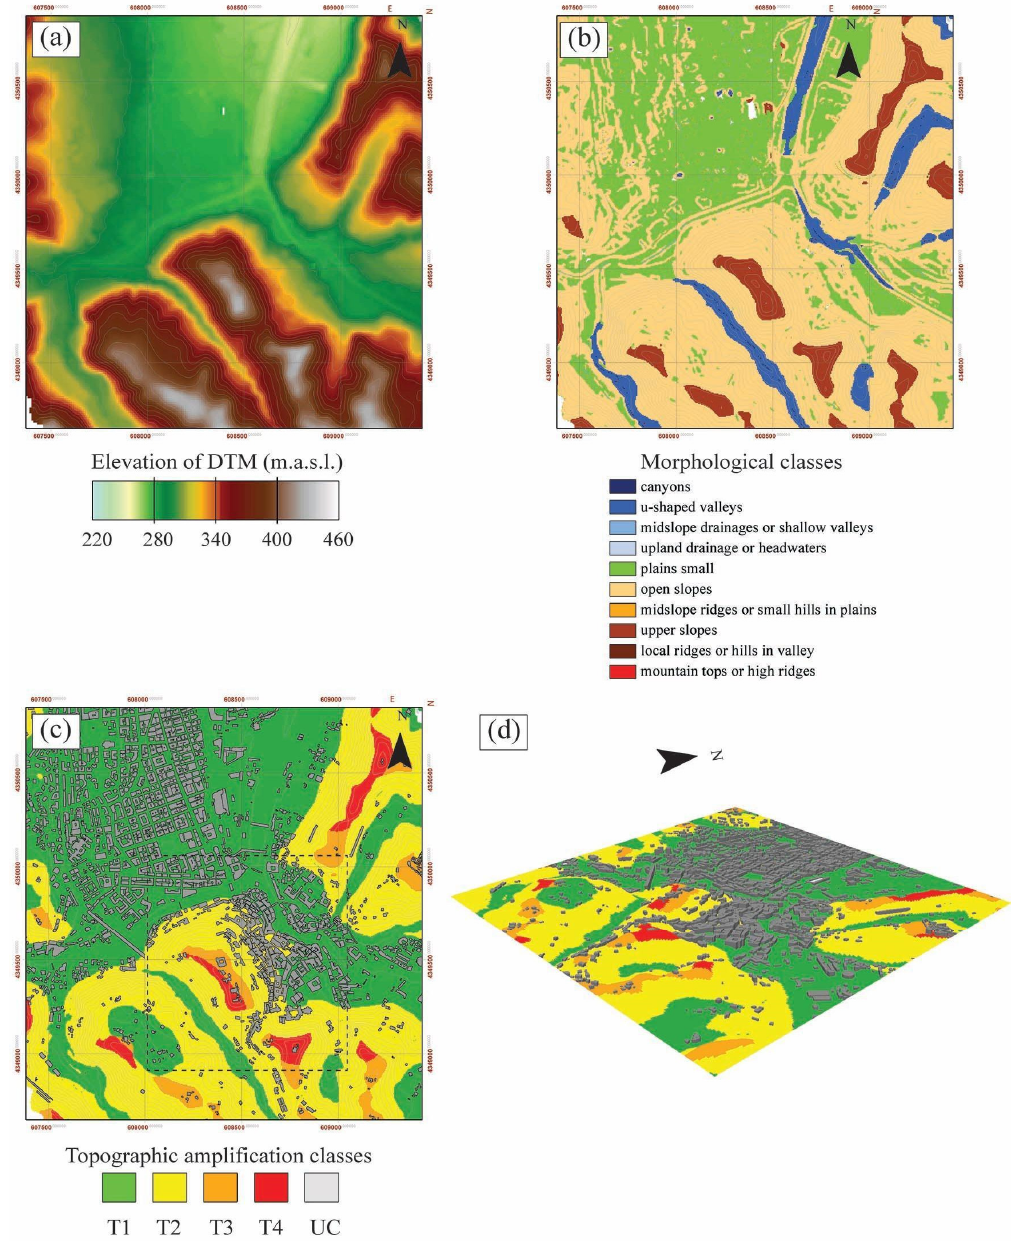
Figure 8. LiDAR-based topographic assessment analysis according to EC8. ( a ) DTM; ( b ) morphological classification according to the modified Weiss procedure; ( c ) 2D map; and ( d ) 3D view of the topographic amplification classes based on the indications of EC8 code.